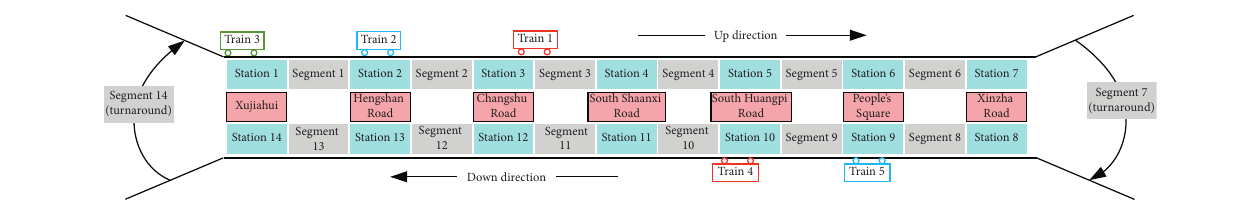
Figure 10: Bidirectional metro line with five trains on two tracks.